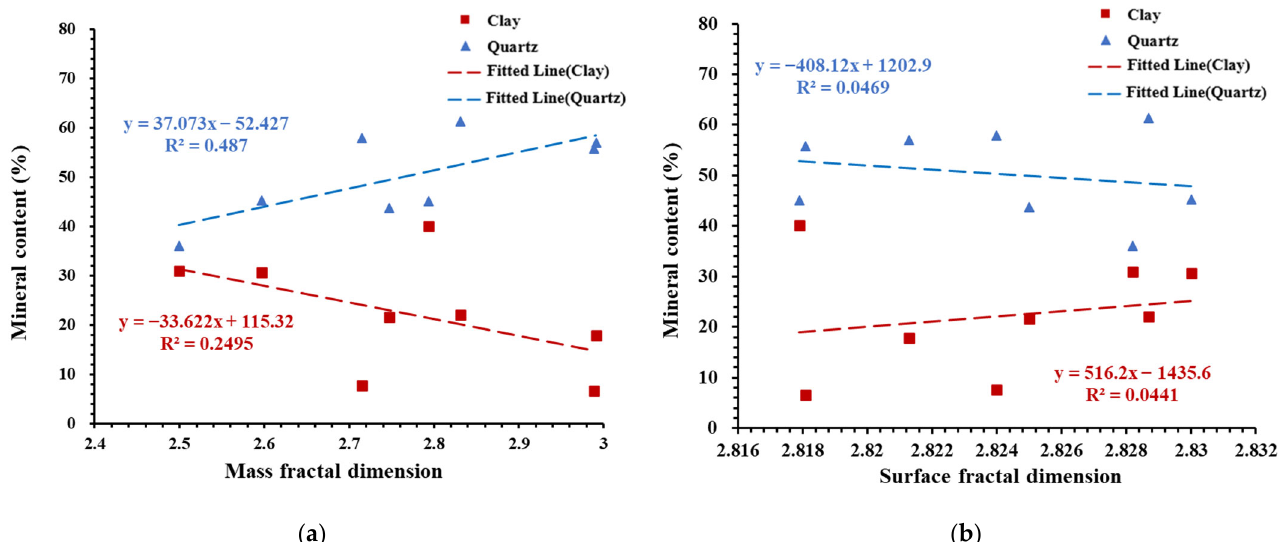
Figure 7. Relationship between the fractal dimension and clay mineral content of deep shale sam ‐